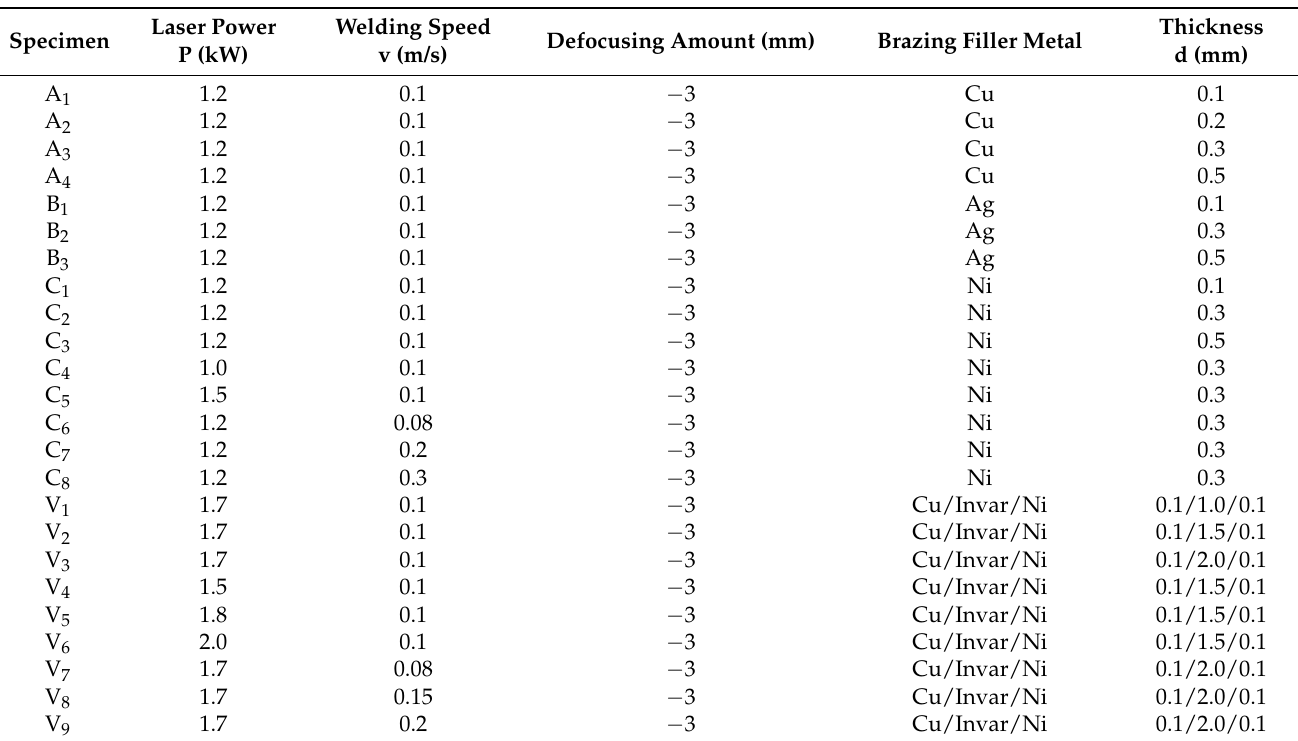
Table 1. Laser welding-brazing parameters of cemented carbides and steels.